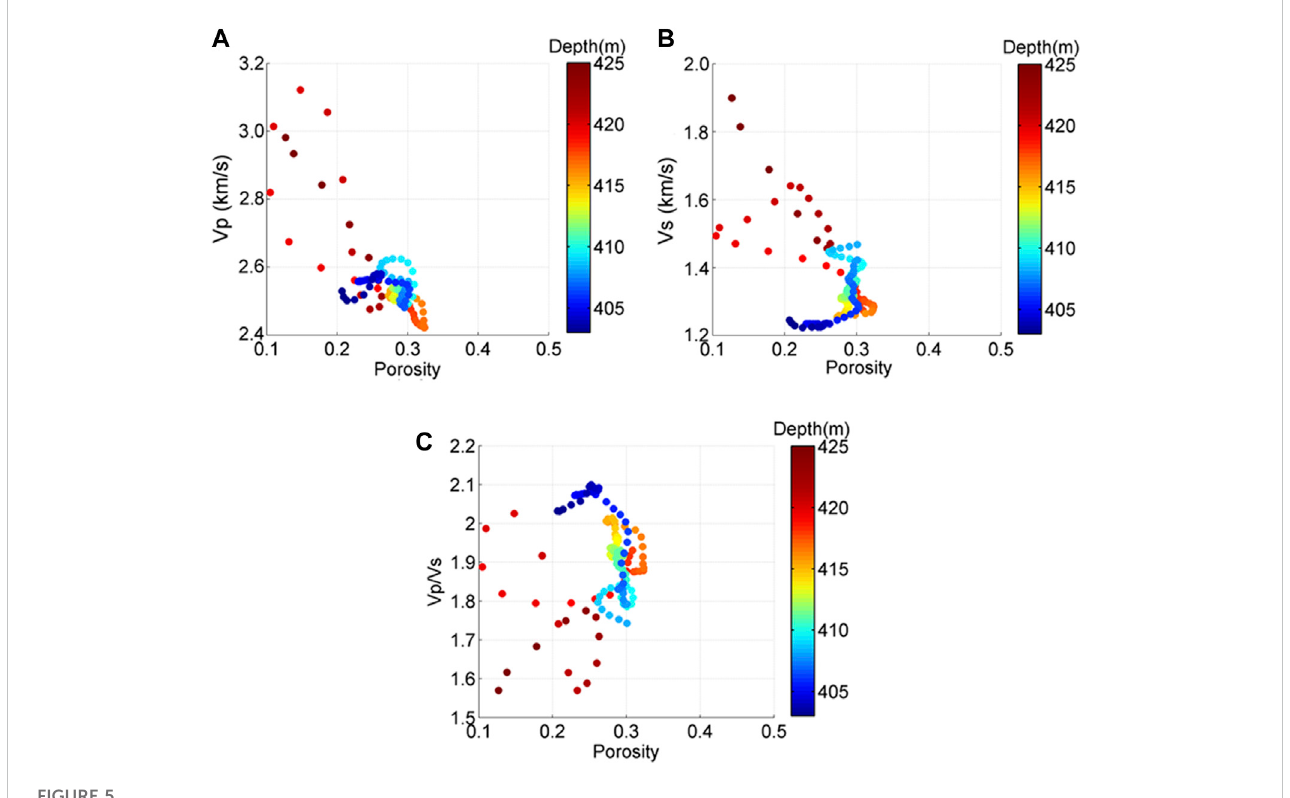
FIGURE 5 Cross-plot of porosity, depth, and (A) Vp, (B) Vs, and (C) Vp/Vs ratio.